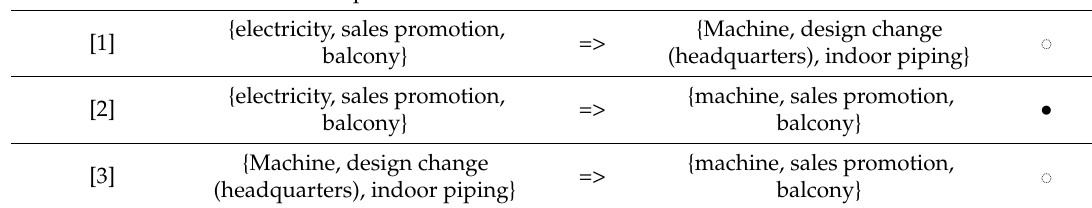
Table 3. Association rule classification system through expert interview.